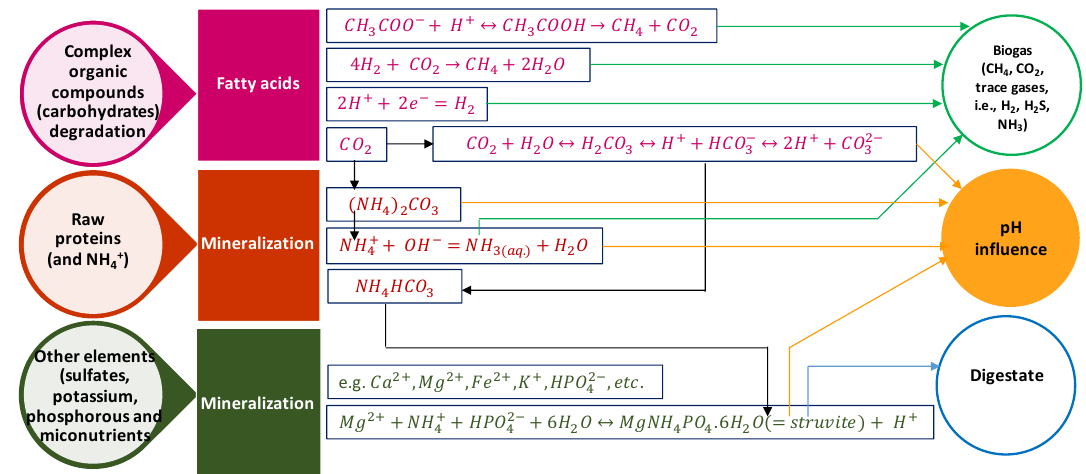
Figure 7. Interaction of degradation pathways and the formation of products influencing pH.